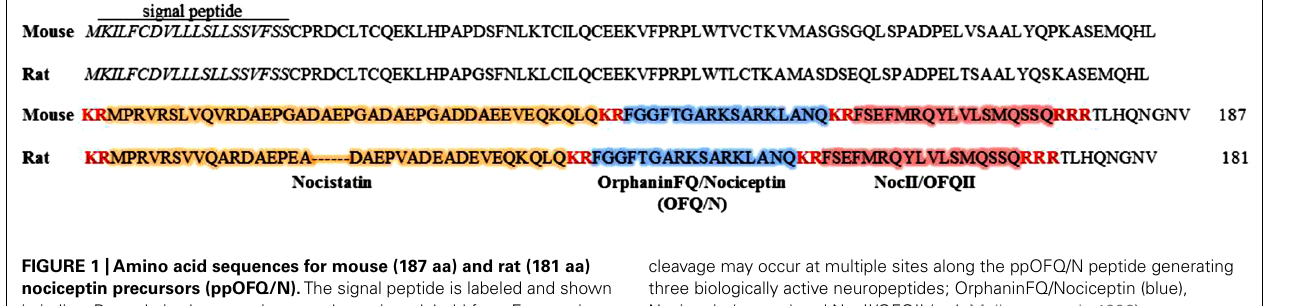
FIGURE 1 |Amino acid sequences for mouse (187 aa) and rat (181 aa) nociceptin precursors (ppOFQ/N). The signal peptide is labeled and shown in italics. Proteolytic cleavage sites are shown in red, bold font. Enzymatic